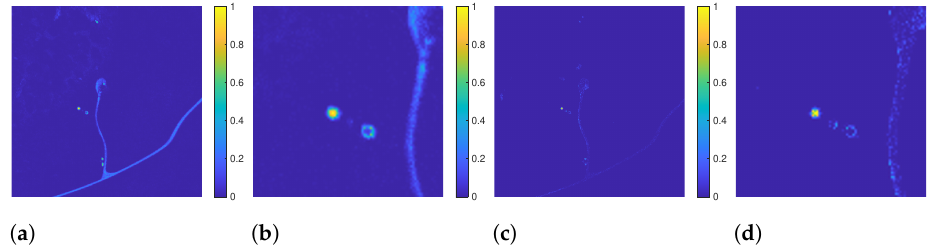
Figure 11. Detection statistics of the ACE algorithm on the full dimensionality data where yellow indicates a response of 1 and blue represents a response of 0. ( a ) Without spatial DR. ( b ) Enlarged version of ( a ). ( c ) With NDVI re . ( d ) Enlarged version of ( c ).